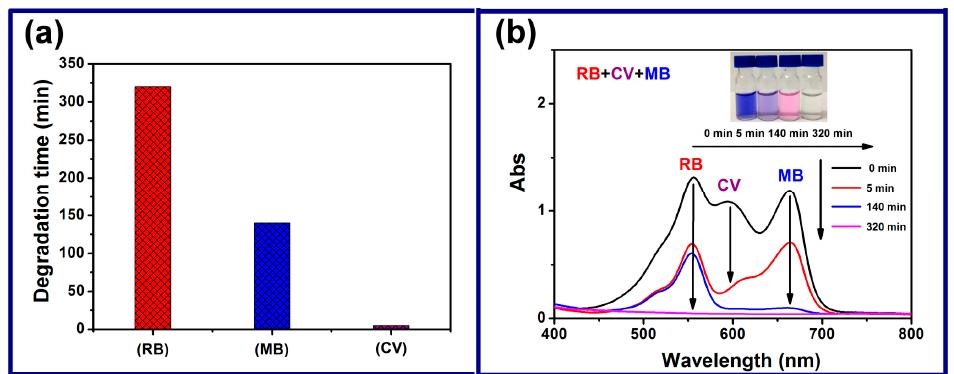
Figure 7. ( a ) Degradation time of different dyes. Experimental condition: Tris-LDH-PW 12 50 mg; H 2 O 2 = 500 µ L; T = 30 ◦ C; Dye = 10 mg/L (50 mL); ( b ) The UV − Vis spectra of degradation mixed dyes. Experiment condition: Tris-LDH-PW 12 50 mg; H 2 O 2 = 500 µ L; total dye = 10 mg/L (50 mL, each dye = 3.33 mg/L); T = 30 ◦ C. Reproduced from Ref. [46], Copyright 2015, WILEY ‐ VCH.